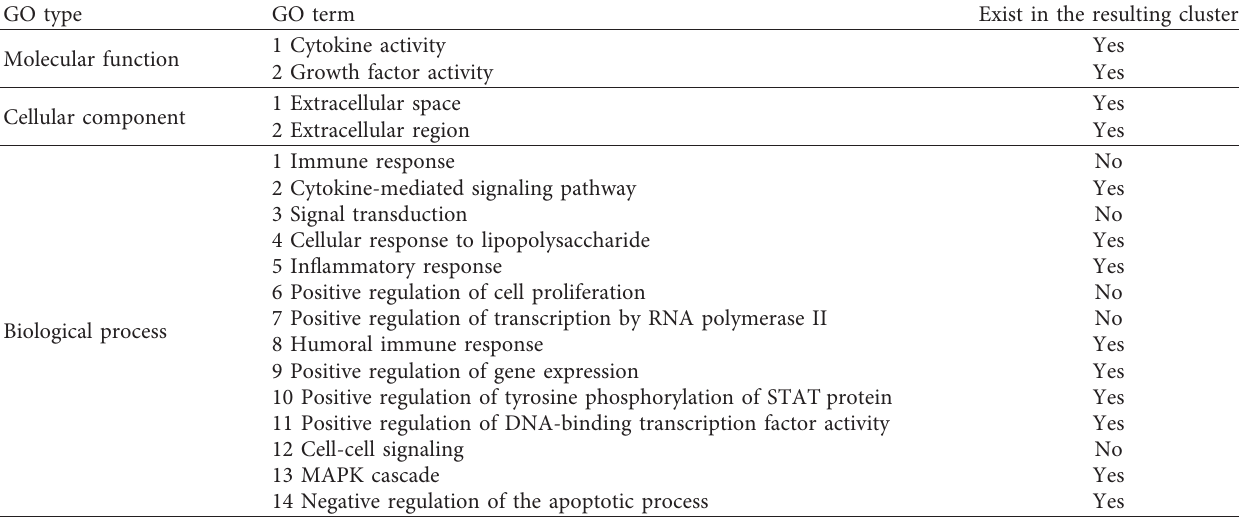
Table 2: GO terms associated with cytokines significant to COVID-19 cytokine storm.